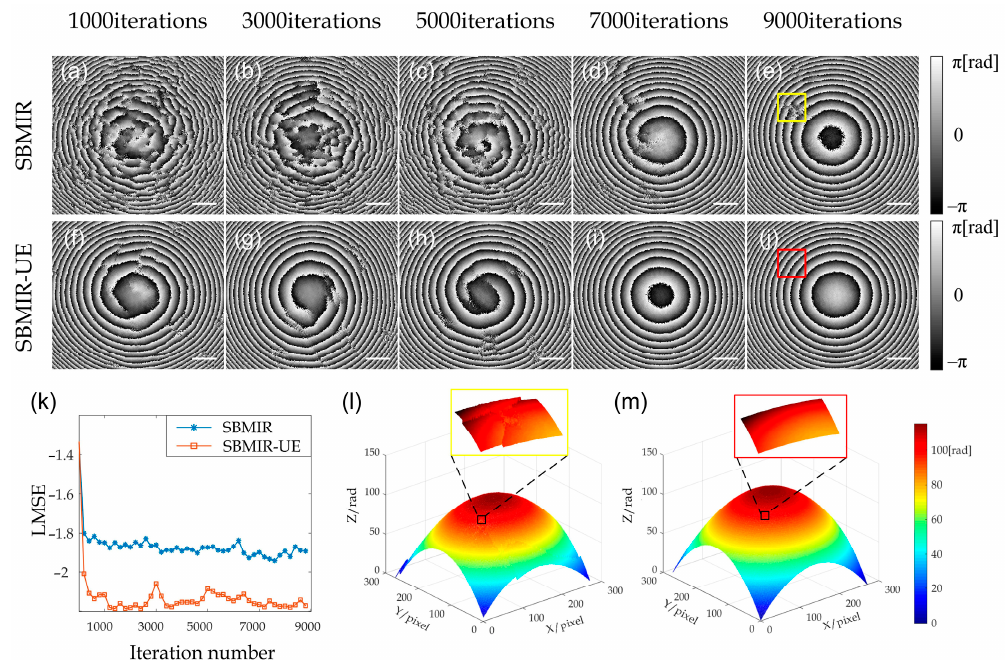
Figure 7. The reconstruction results of a lens. ( a-e ) and ( f-j ) are the reconstructed phase images using SBMIR and SBMIR-UE algorithm after 1000, 3000, 5000, 7000 and 9000 iteration times, respectively; ( k ) corresponding LMSE plots for increasing number of iterations; ( l , m ) the unwrapped reconstructed phase using SBMIR and SBMIR-UE, respectively. The white bars in ( a – j ) indicate the length of 300 μ m.